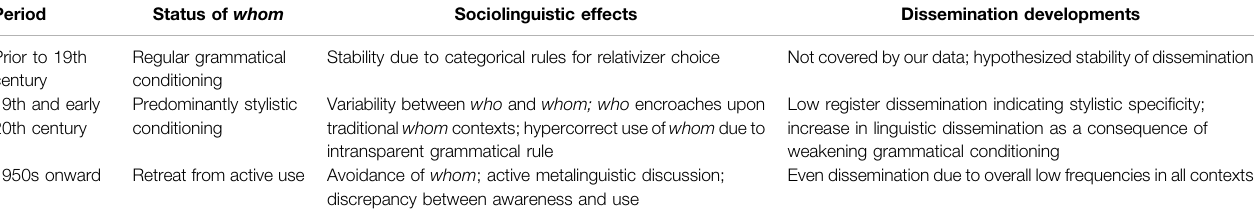
TABLE 3 | Three developmental stages of